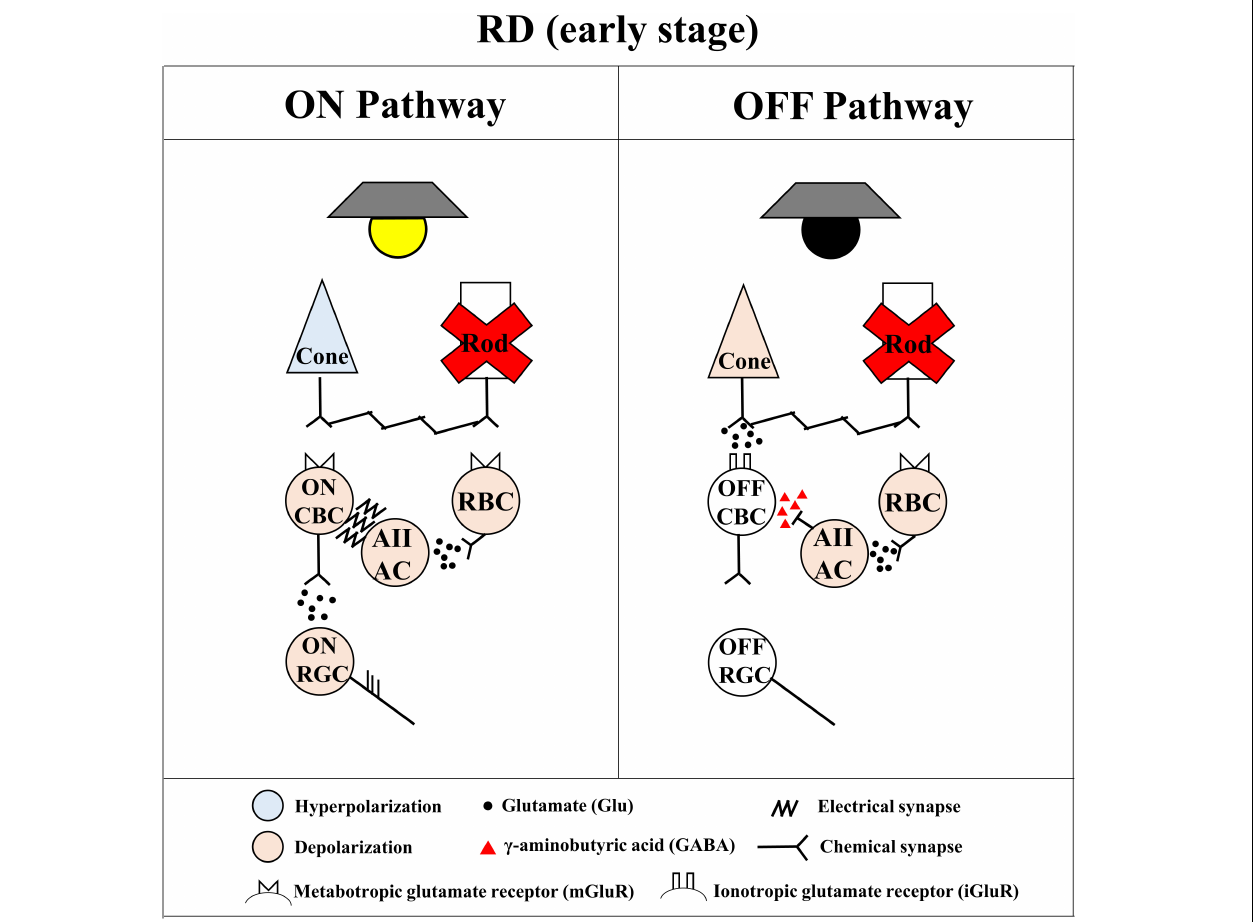
FIGURE 9 | Simple diagram of spiking pathway of ON and OFF retinal ganglion cells (RGCs) in the retinal degeneration (RD) to the mesopic light stimulation. The simple diagram of ON and OFF pathways in the degenerated retina. The stimulated cone photoreceptors affect both ON cone bipolar cells (ON CBCs) and OFF cone bipolar cells (OFF CBCs) via the metabotropic glutamate receptor (mGluR) and the ionotropic glutamate receptor (iGluR)-mediated chemical synapse, respectively. The ON and OFF CBCs directly connect with ON and OFF RGCs, respectively, generating their spikes with glutamatergic input. On the other hand, the stimulated rod photoreceptors affect only rod bipolar cells (RBCs) via the mGluR. The RBCs indirectly connect with ON and OFF RGCs through AII ACs. The AII ACs synapse with ON and OFF RGCs via the gap junction channel-mediated electrical synapse and GABAergic synapse, respectively. In the case of RD, the rod pathway cannot show electro-pharmacological alteration even if the OFF light stimulation activates the OFF pathway.